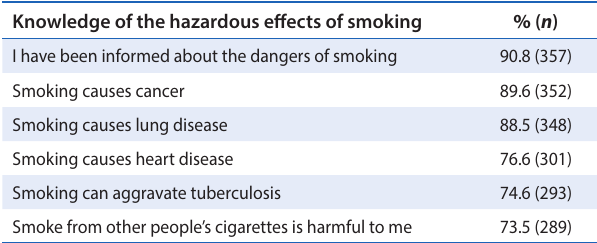
Table 2: Knowledge of the effects of smoking on health Knowledge of the hazardous effects of